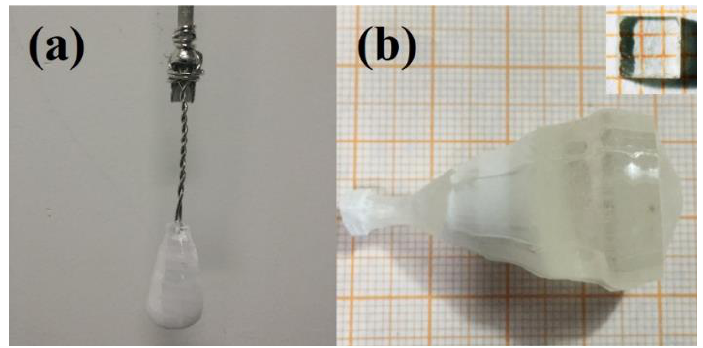
Figure 2. ( a ) Yb 3+ :ScBO 3 crystal grown with a seed of platinum wire, ( b ) optical-quality Yb 3+ :ScBO 3 crystal. Inset: cut and polished laser sample. (Source: [34], © 2015 Optica Publishing Group, Washington, DC, USA).